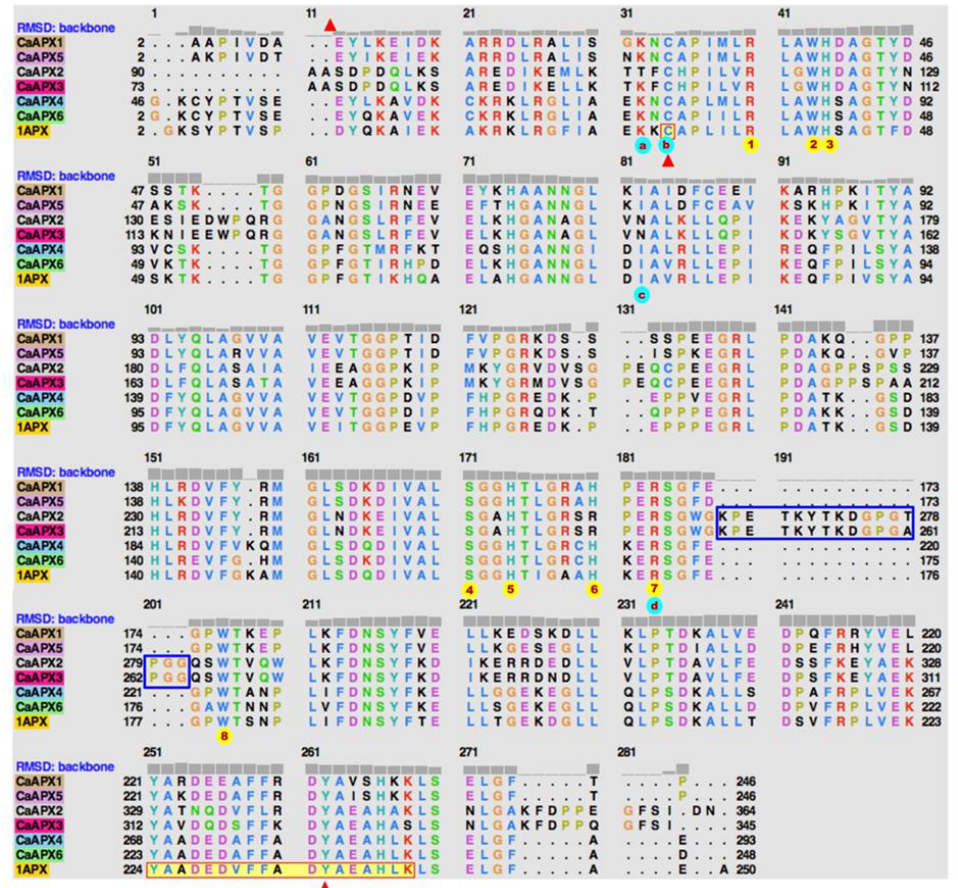
Figure 8. Alignment of the primary structure of the six CaAPX isozymes and the pea cytosolic APX (1APX) resulting from the superimposition of the coordinates of CaAPX isozymes on the structure of 1APX. Residues comprising the active site of 1APX (R38, W41, H42, S160, H163, H169, R172, and W179) are denoted by a number in red encircled in yellow. Residues involved in the interaction with ascorbic acid (K30, C52, I76, R172) are denoted by a letter in red encircled in blue. Residues reported to undergo NO-derived PTMs are highlighted by a red solid triangle and the peptide identified by MS/MS is shown on a yellow background. The loops present in CaAPX2 and CaAPX3 are enclosed in blue rectangles.